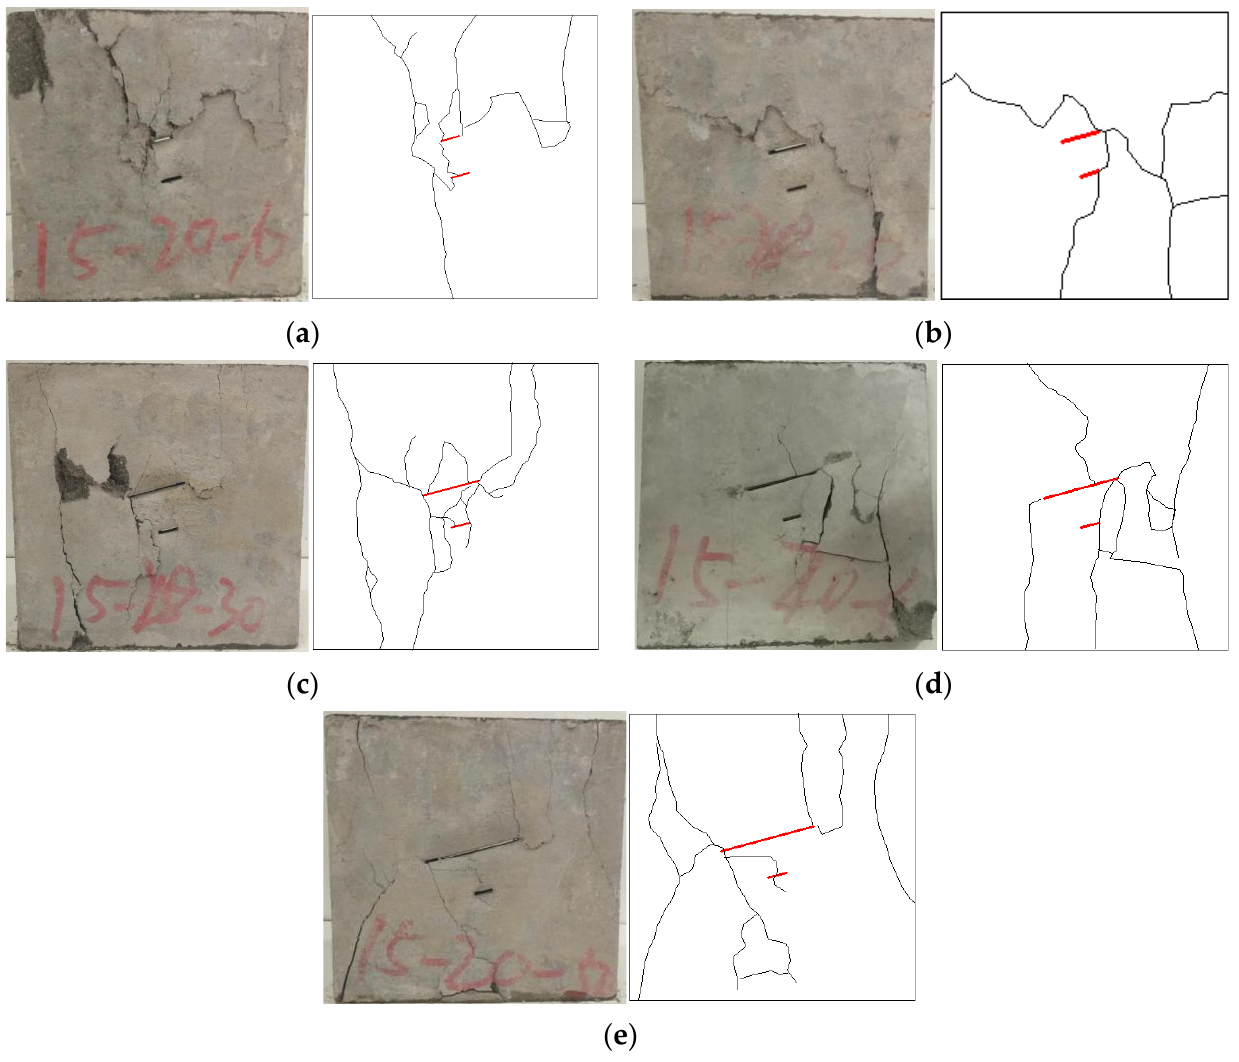
Figure 7. Influence of preexisting fissure length on crack propagation and coalescence. ( a ) Failure specimen 15-20-10; ( b ) 15-20-20; ( c ) 15-20-30; ( d ) 15-20-40; ( e ) 15-20-50.